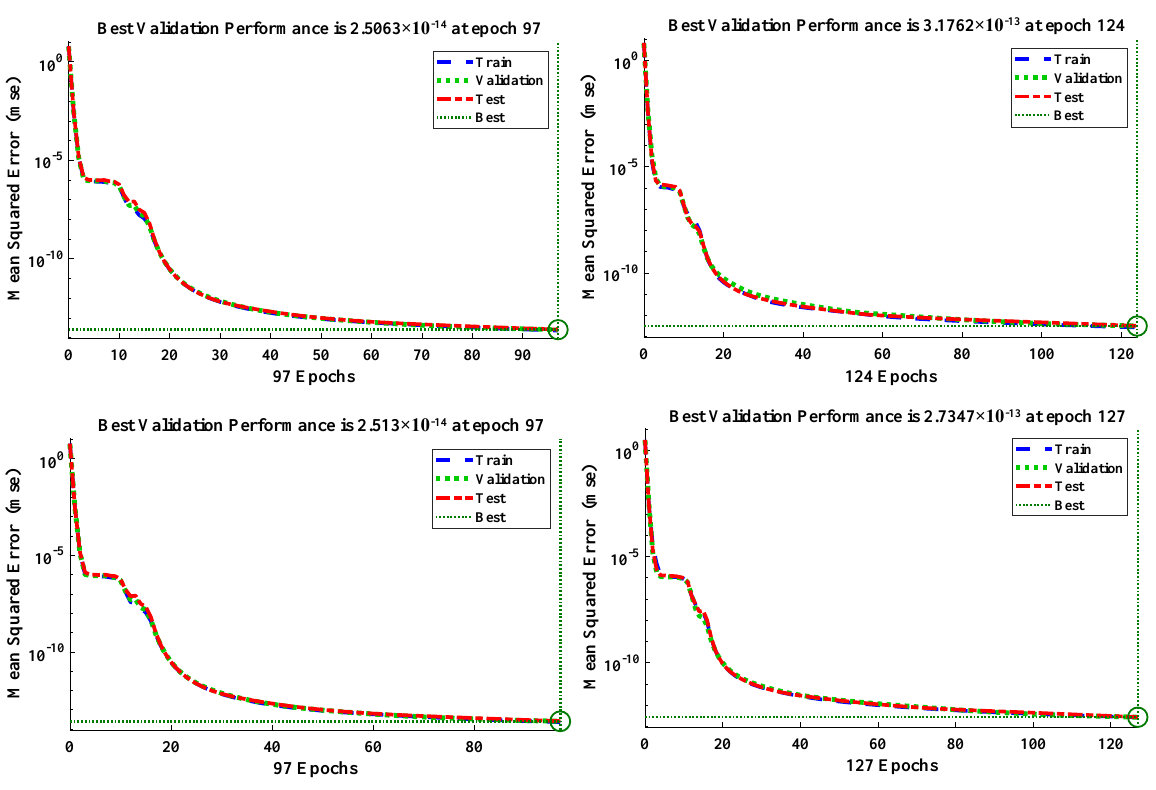
Figure 7. Convergence of the objective function with regard to the mean square error for distinct boundary